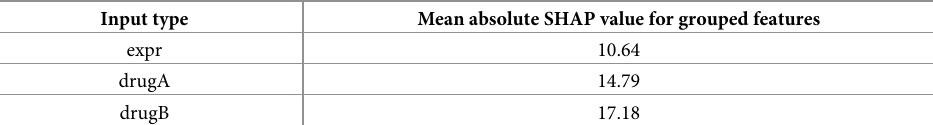
Table 2. Mean absolute SHAP values for features grouped by input type. SHAP values for groups of features were calculated by summing the SHAP values of all of the individual features, and then the mean absolute SHAP value across all samples was calculated for the grouped